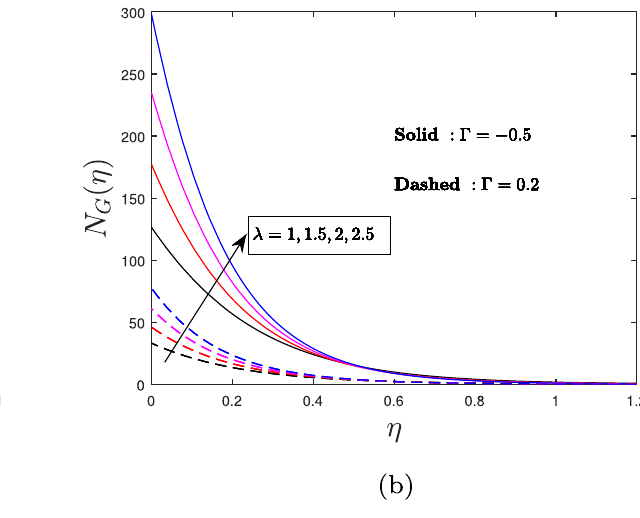
Figure 16: Entropy generation pro fi les against ( a ) Λ and ( b ) λ .